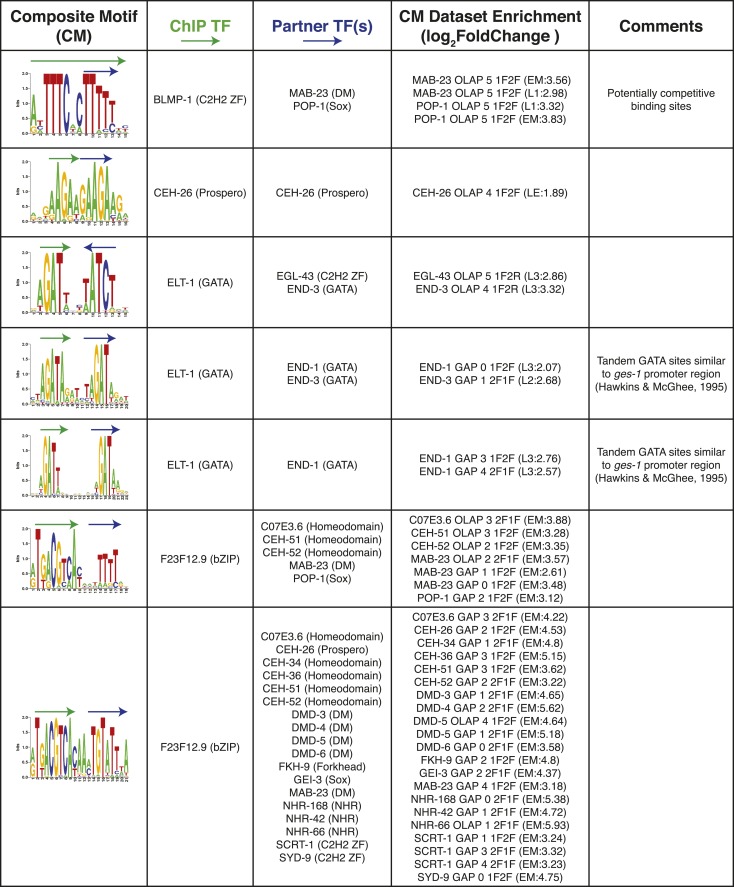
Summary of clustered CMs enriched in C. elegans ChIP-seq peaks.CM-cluster centroids are shown for the enriched motifs. For each cluster, the ChIPed TF(s) and potential partner TF(s) are listed along with information about motif overlap (OLAP), spacing (GAP), and enrichment. Colored arrows over motif indicate high-information content portions of either factor.